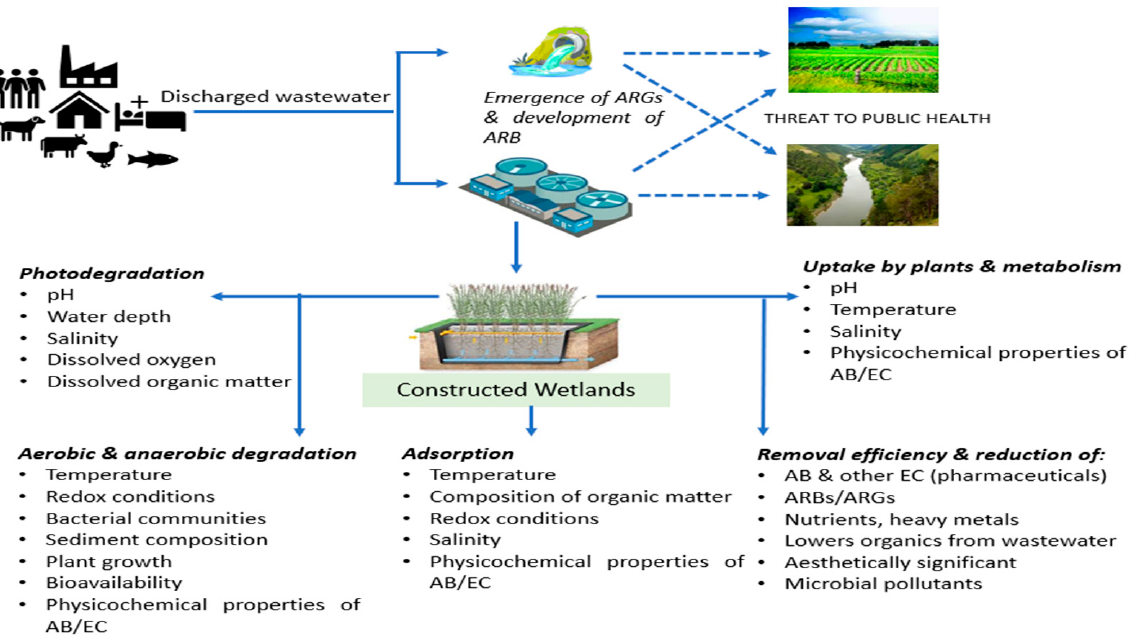
Figure 1. Source, development, pathway and potential threats of ARB/ARGs on the environment, and application of constructed wetlands through various mechanisms for the reduction of the same (Note: ARGs—antibiotic resistant genes; ARB—antibiotic resistant bacteria; AB—antibiotics, EC—emerging contaminants).